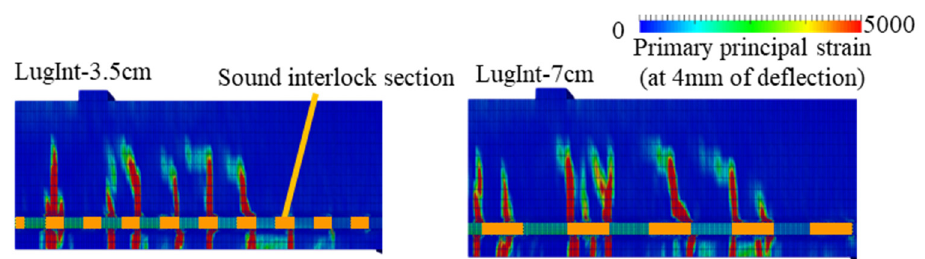
Figure 17. Flexural crack distribution before shear cracking (non-uniform loss of lugs in axial direc-